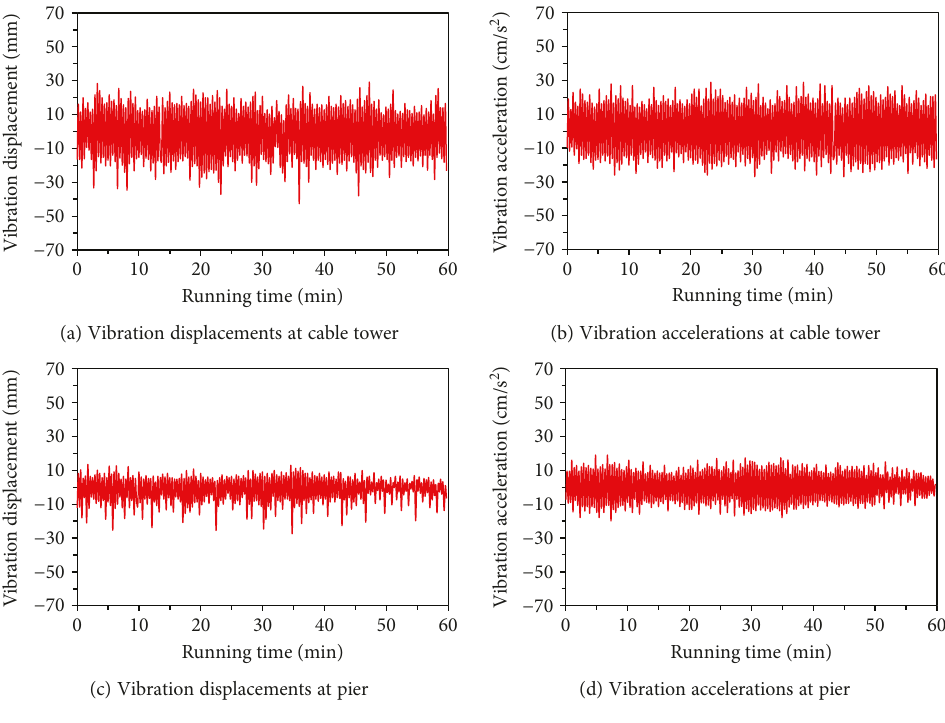
Figure 9: Vibration responses at di ff erent positions of long-span bridges.